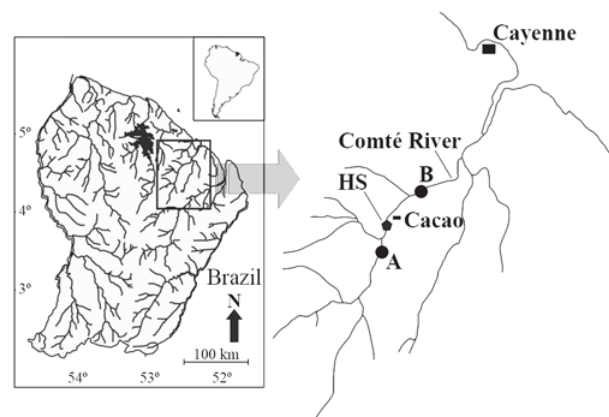
Fig. 1. Localization of the sampling sites on the Comté River, French Guiana. A = upstream site; B = downstream site; HS = Hydrological